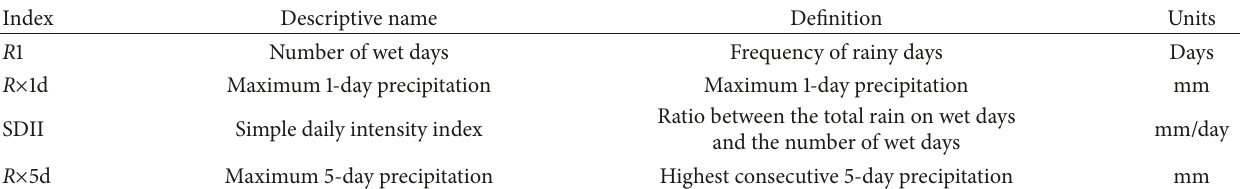
Table 1: Summary of rainfall indices used in the study (a wet day is defined as a day with at least 1 mm of precipitation).